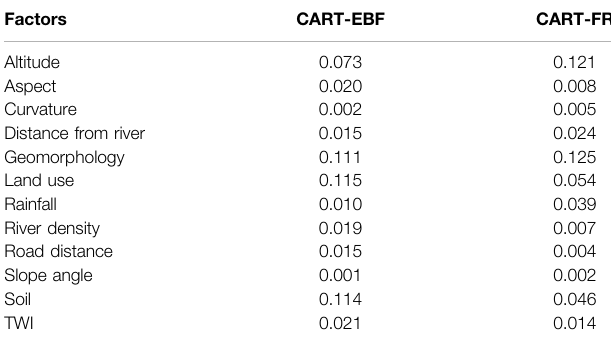
TABLE 5 | Weights of conditioning factors within the applied